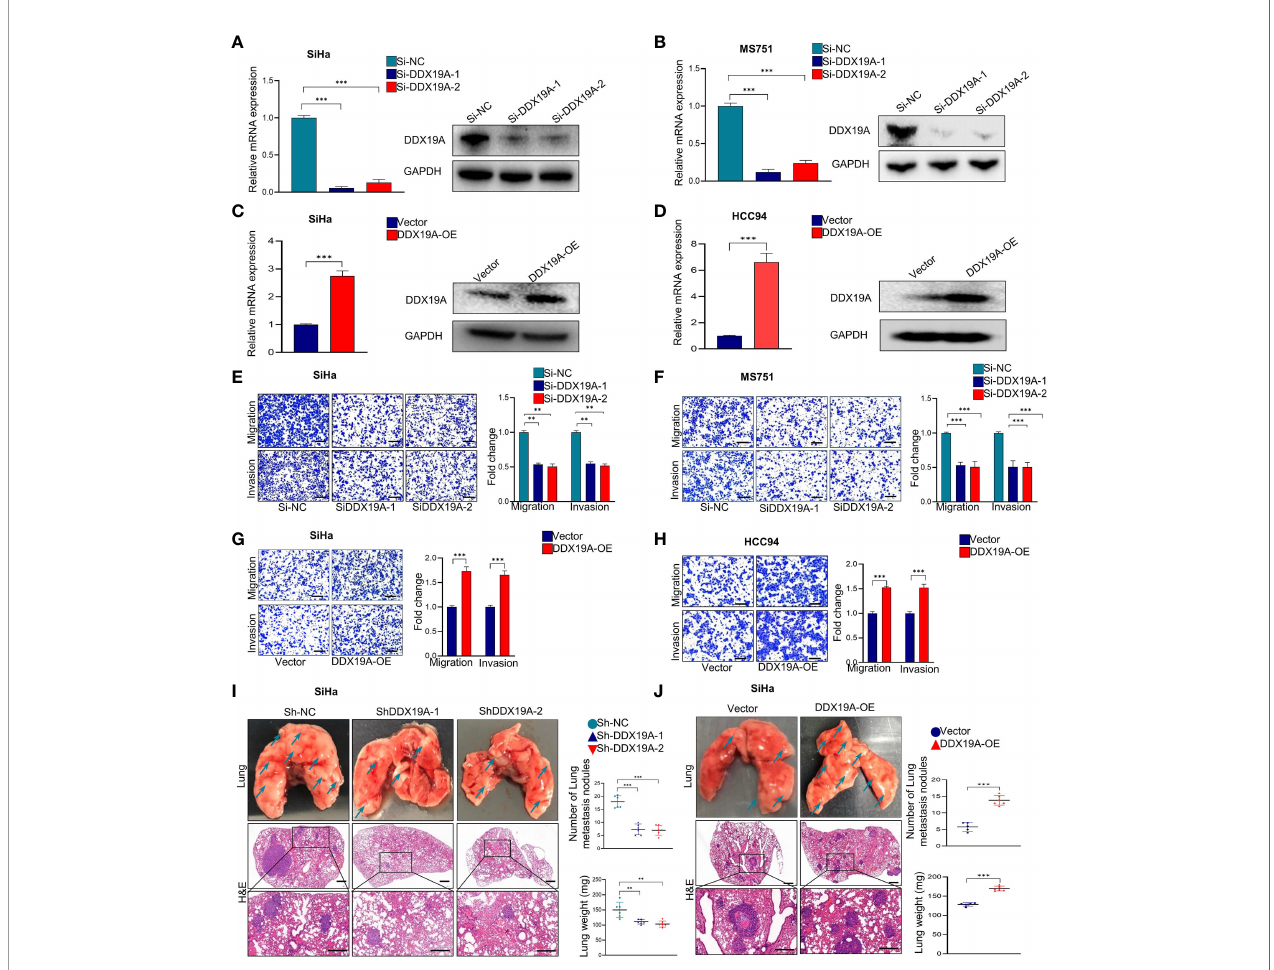
FIGURE 2 | DEAD-box helicase 19A (DDX19A) promotes the metastasis of cervical squamous cell carcinoma (CSCC) cells in vitro and in vivo . (A, B) qRT-PCR and Western blot were employed to evaluate the ef fi cacy of DDX19A mRNA and protein knockdown in SiHa and MS751 (n = 3). (C, D) qRT-PCR and Western blot were employed to evaluate the ef fi cacy of DDX19A mRNA and protein overexpression in SiHa and HCC94 (n = 3). (E, F) Cell migration assay and Matrigel invasion assay were employed to investigate the effect of DDX19A knockdown in SiHa and MS751 cell migration and invasion ability (scale bar: 200 m m) (n = 3). (G, H) Cell migration assay and Matrigel invasion assay were employed to investigate the effect of DDX19A overexpression in SiHa and HCC94 cell migration and invasion ability (scale bar: 200 m m) (n = 3). (I, J) Arrows showed the representative results of metastatic lung nodules. H&E staining was used to stain metastatic lung nodules (200× and 400× magni fi cation; scale bar: 200 m m). Dot plots showed the results of the number of lung metastasis nodules and lung weight (n = 6). Results represent three independent experiments (A – H) . The results were shown as means ± SD, ** p < 0.01, *** p < 0.001 by two-tailed Student ’ s